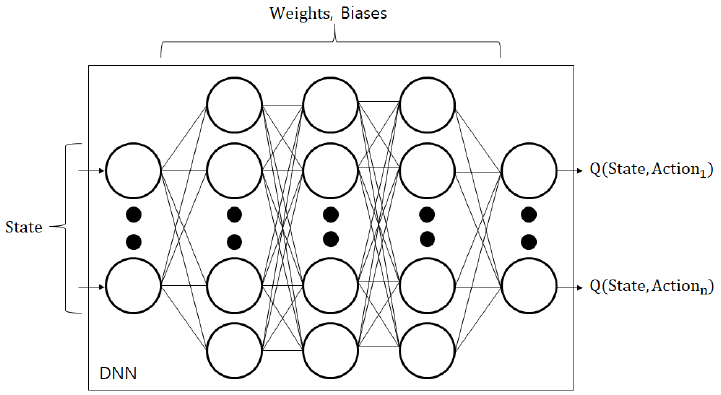
Figure 3. A Q-network of the DQN